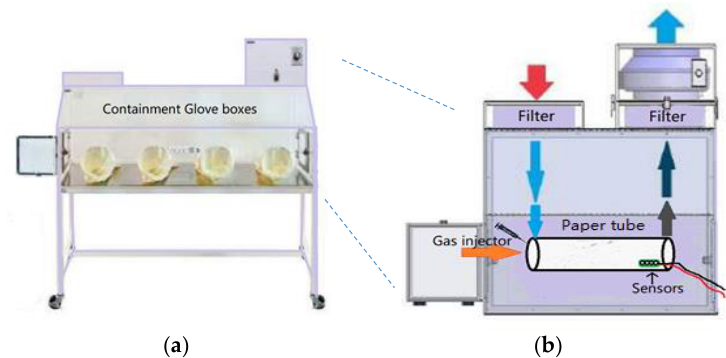
Figure 1. ( a ) A picture of the glove box used in this work, ( b ) a schematic of the experimental system for flow through gas